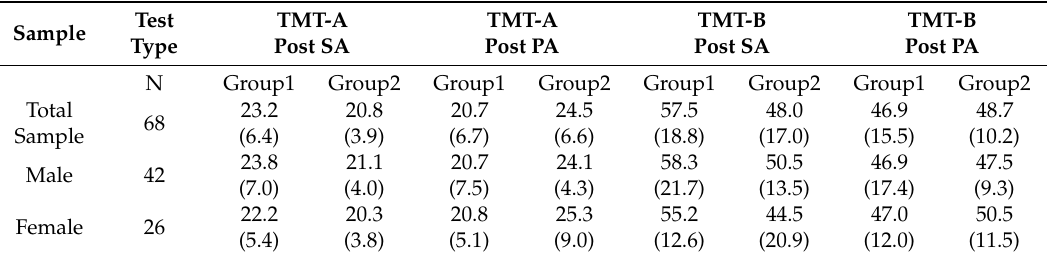
Table 2. Trail Making Test A and B performance (in seconds) for the total sample, within sex groups, and within allocation group order (means and standard